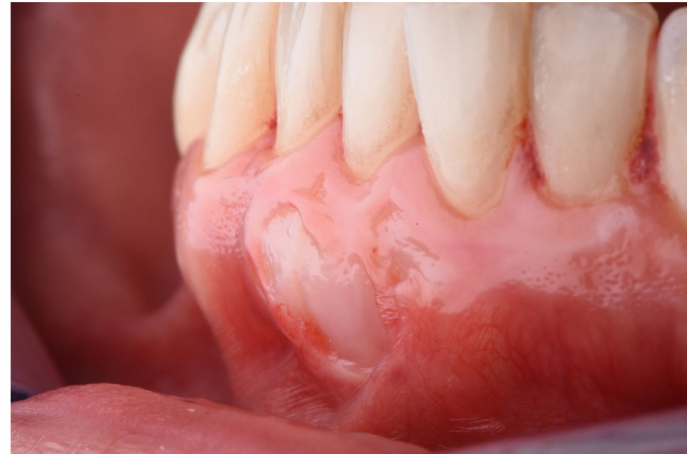
Figure 2. Superficial re-epithelialization.